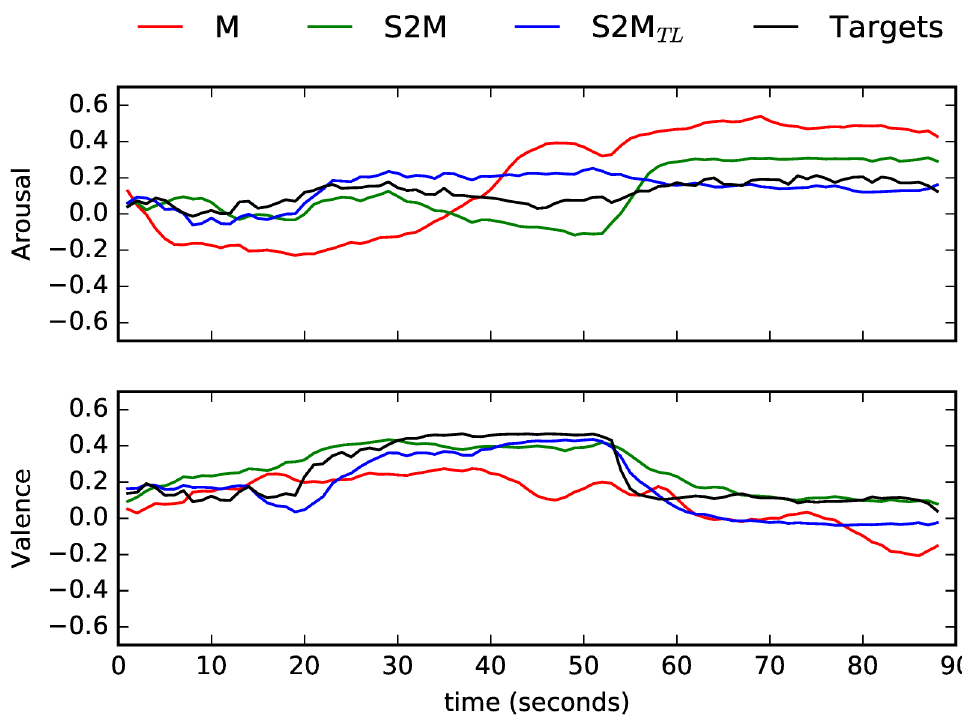
Fig 3. Time-continuous Arousal and Valence predictions by the intra- ( M ) and cross-domain ( S 2 M , S 2 M TL ) models for a representative music piece: T he Searchers, Suite (taken from M DB The goldenstandard is also shown